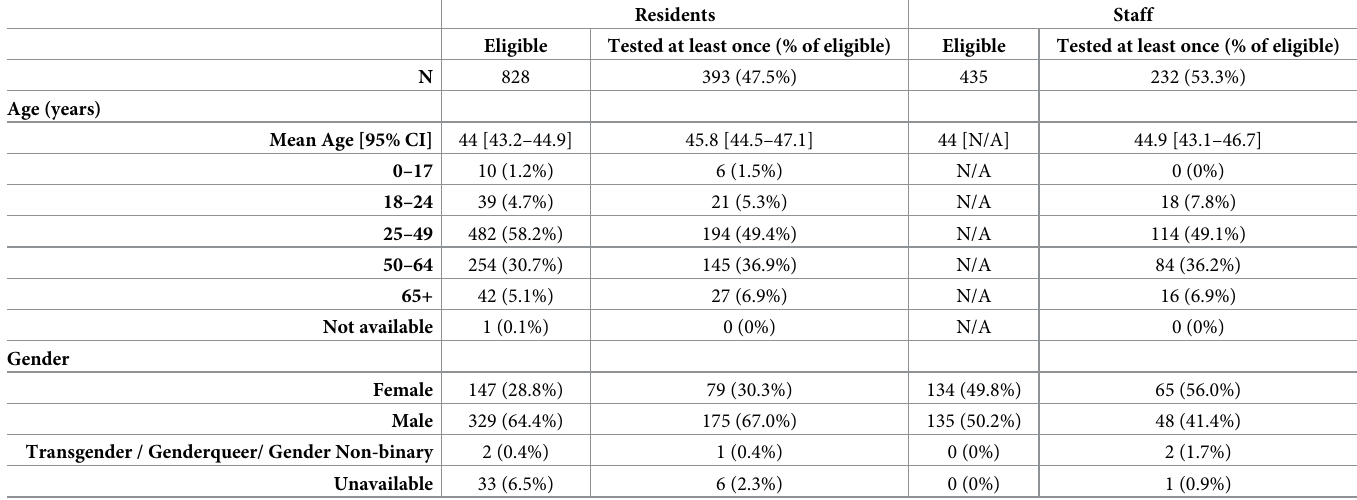
Table 3. Characteristics of shelter residents and staff during implementation of rapid SARS-CoV2 antigen testing at homeless shelters, San Francisco, 2021.